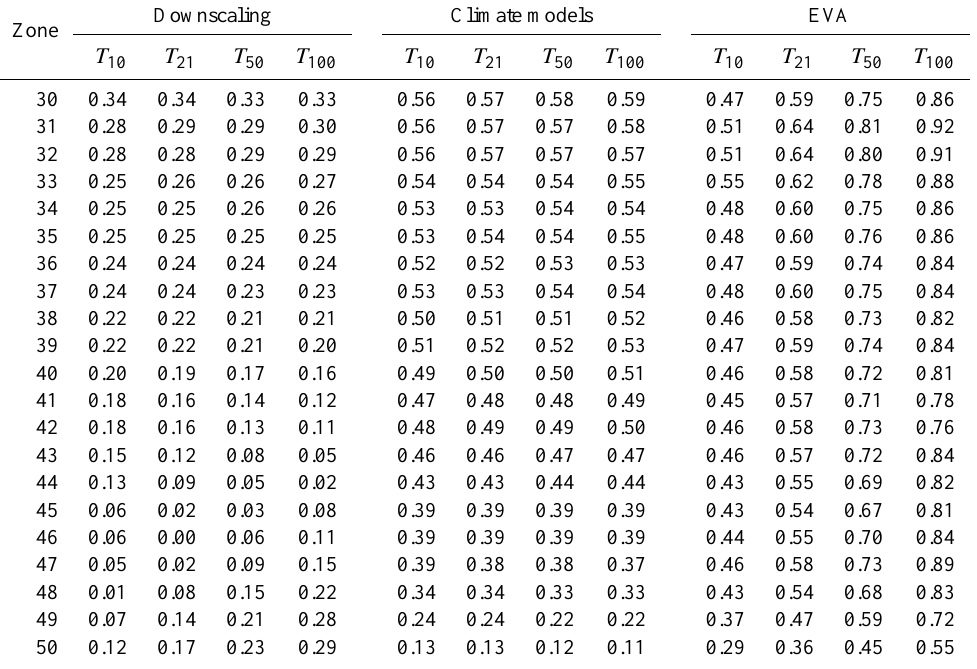
Table 4. Uncertainty estimates from downscaling, climate models and extreme value analysis at zones 30–50 for all return periods as four standard deviations of hydraulic head in